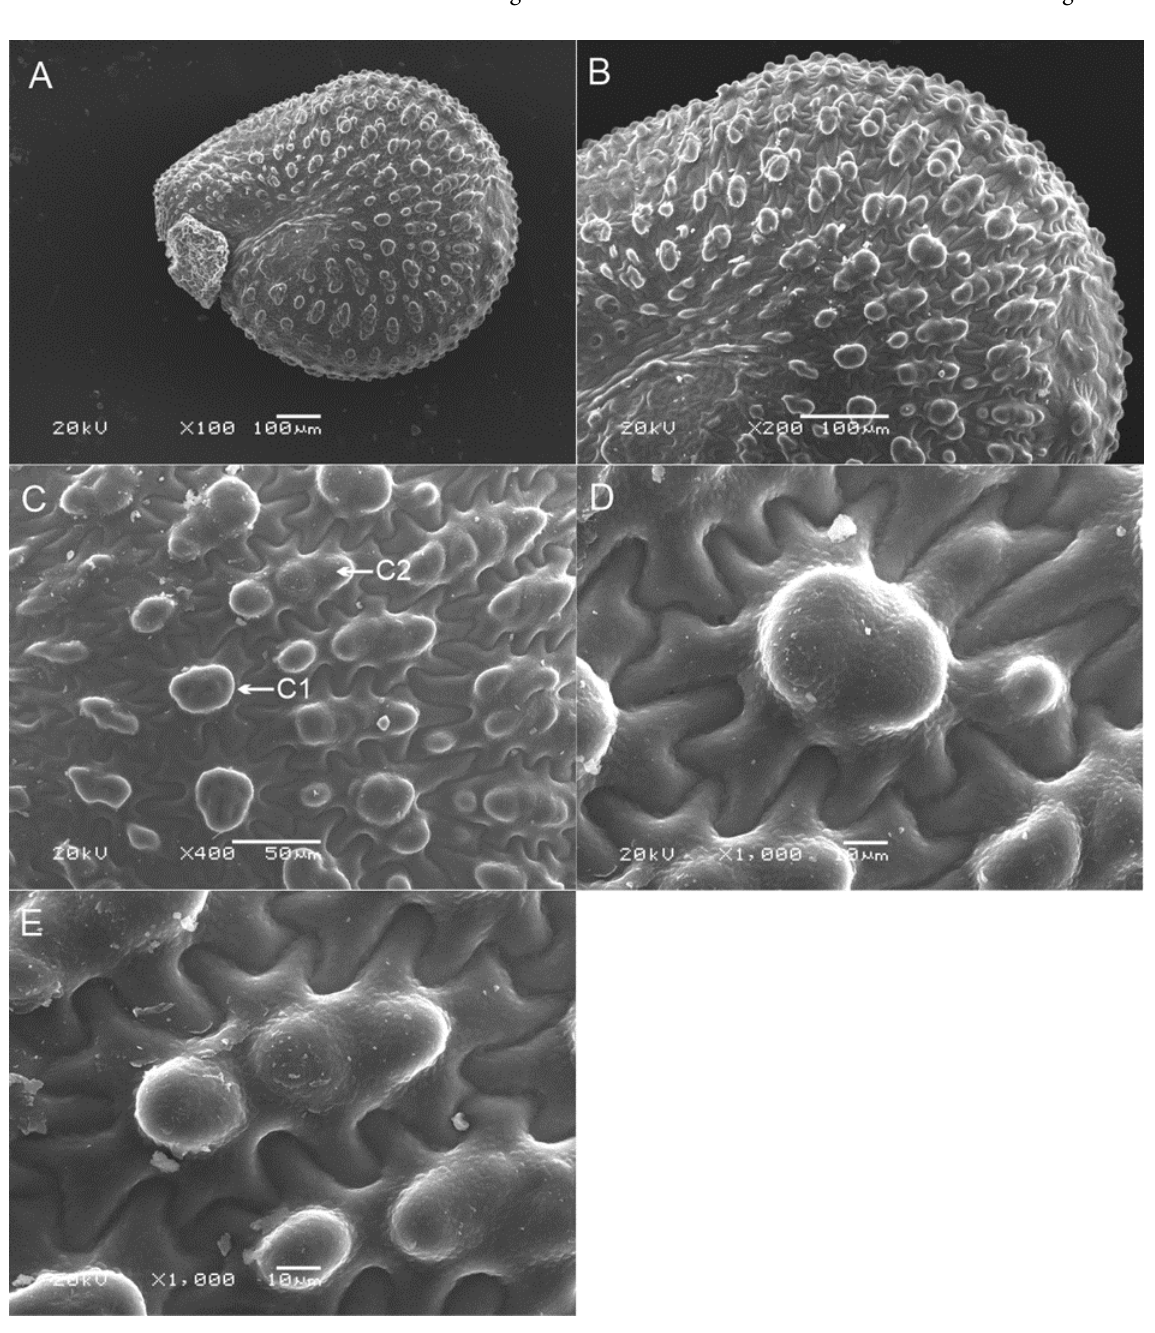
Figure 2 Portulaca daninii (SEM). General view of the seed ( A ). e seed surface ( B,C ). Isodiametric cell ( C1 ), elongated cell ( C2 ); general view of the cells ( D,E